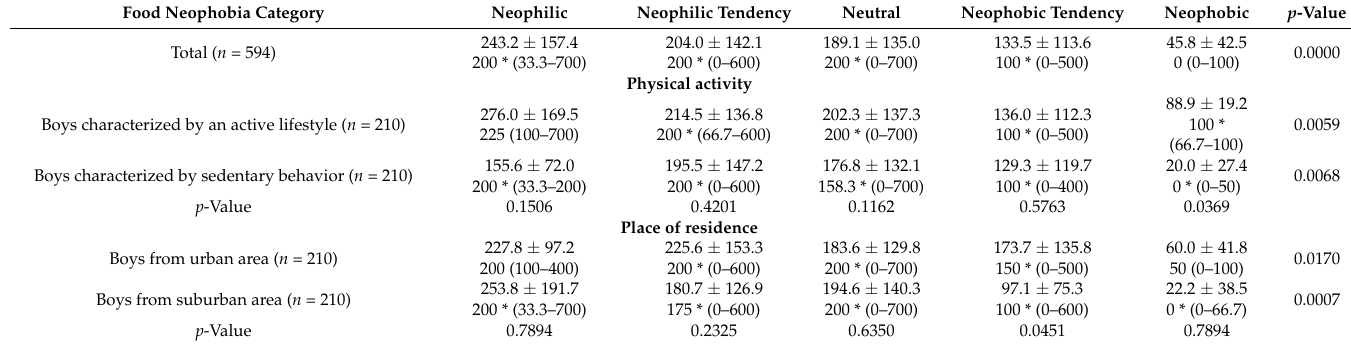
Table 3. Fruit intake (g/day) for boys in Food Neophobia Scale categories—mean ± SD, as well as median, minimum, and maximum values are presented for food neophobia categories and compared between subgroups characterized by an active lifestyle ( n = 210) and by sedentary behavior (n = 210), as well as from urban area ( n = 210) and suburban area ( n =